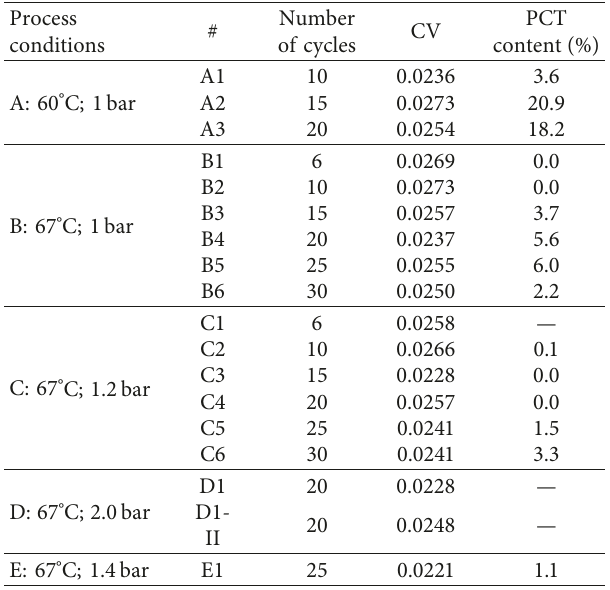
Table 7: CV and PCT content values for run process conditions.